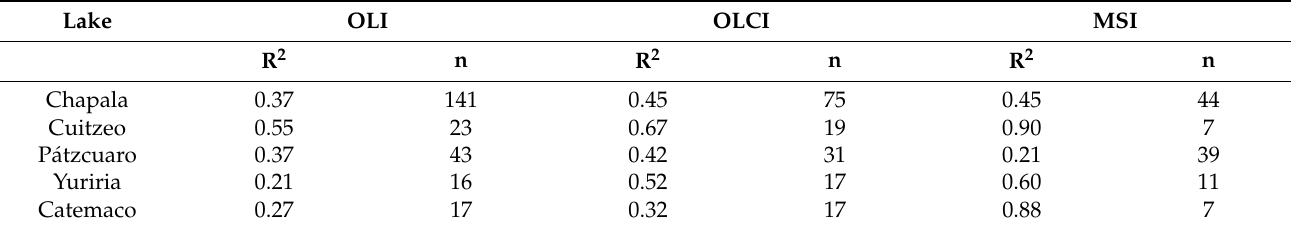
Table 2. Average coefficient of determination (R 2 ) of the developed models by sensor and lake Table 3. Average error metrics of the trained models by sensor and water parameter. Error metrics of all lakes are included on each water parameters RMSE: Chla in mg m − 3 , Turbidity in NTU, TSM in g m − 3 , SDD in m. The number of samples is also displayed on